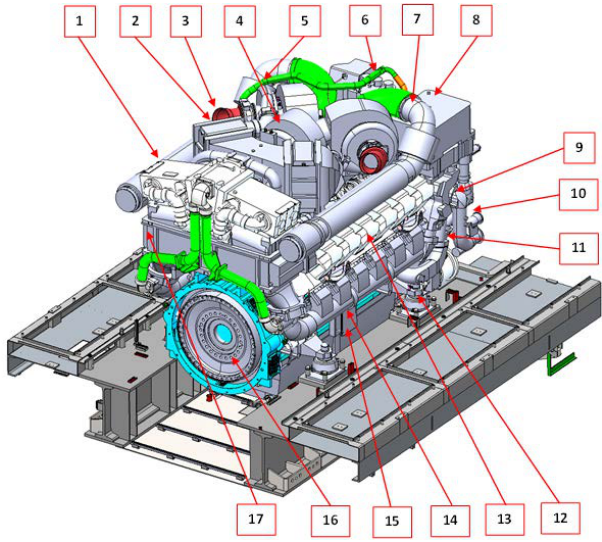
Fig. 10. MTU 12V4000R84 combustion engine, where: 1 – exhaust gas recirculation cooler (EGR cooler), 2 – charge air cooler (high